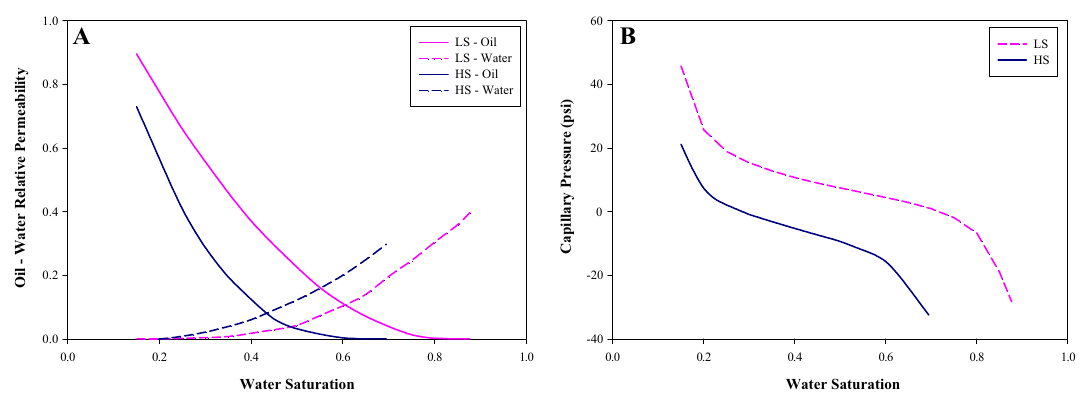
Fig. 1 a Oil/water relative at HSW and LSW conditions, b comparison of capillary pressure between HSW and LSW condition (Omekeh et